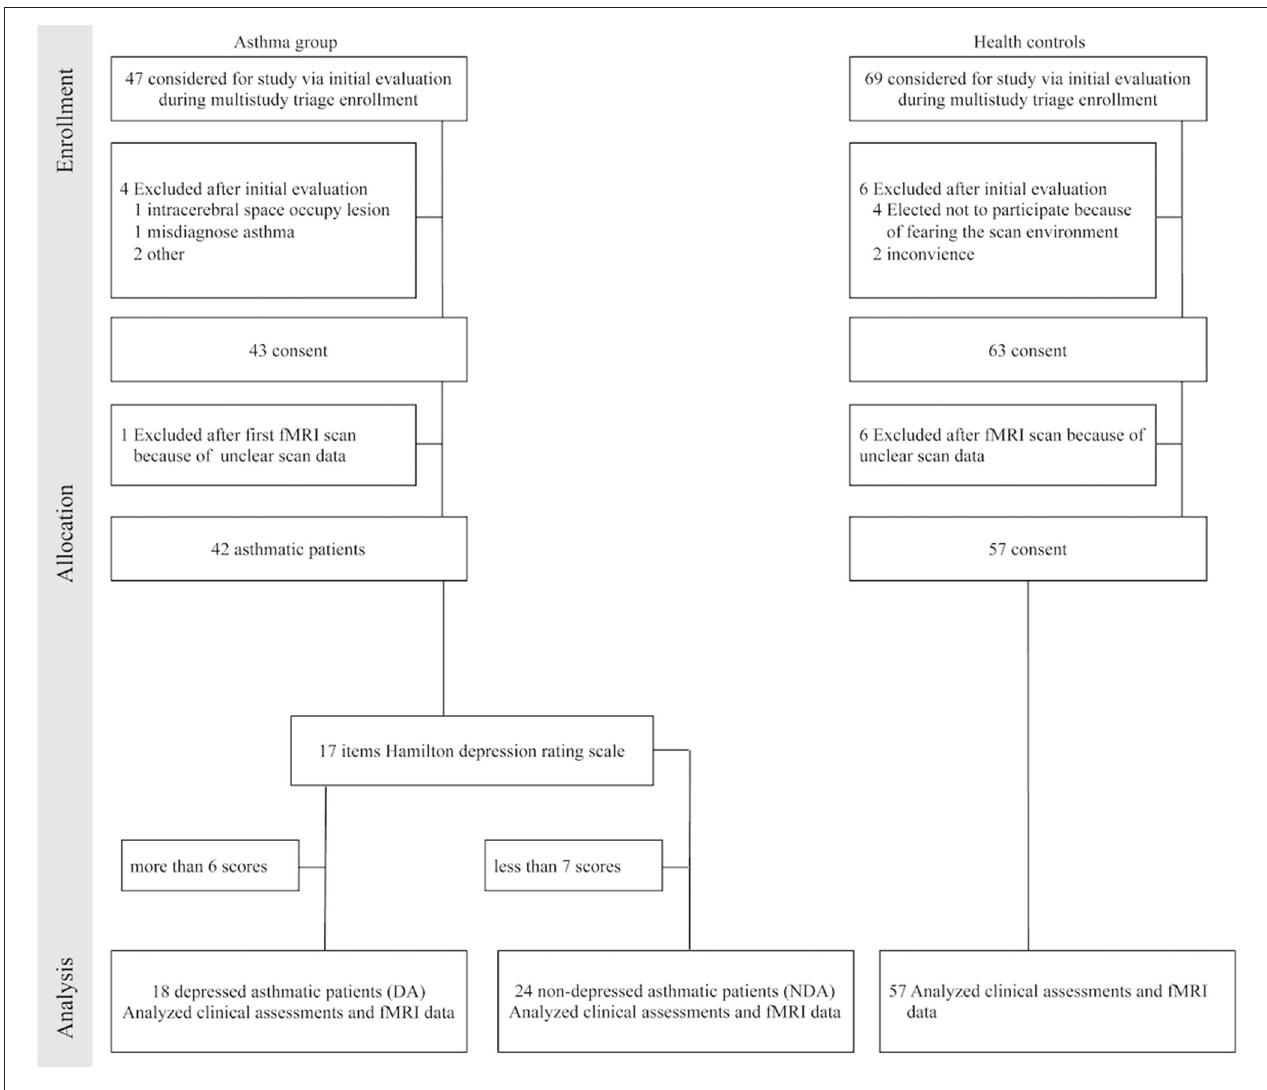
FIGURE 1 | Flow diagram. fMRI indicated functional magnetic resonance